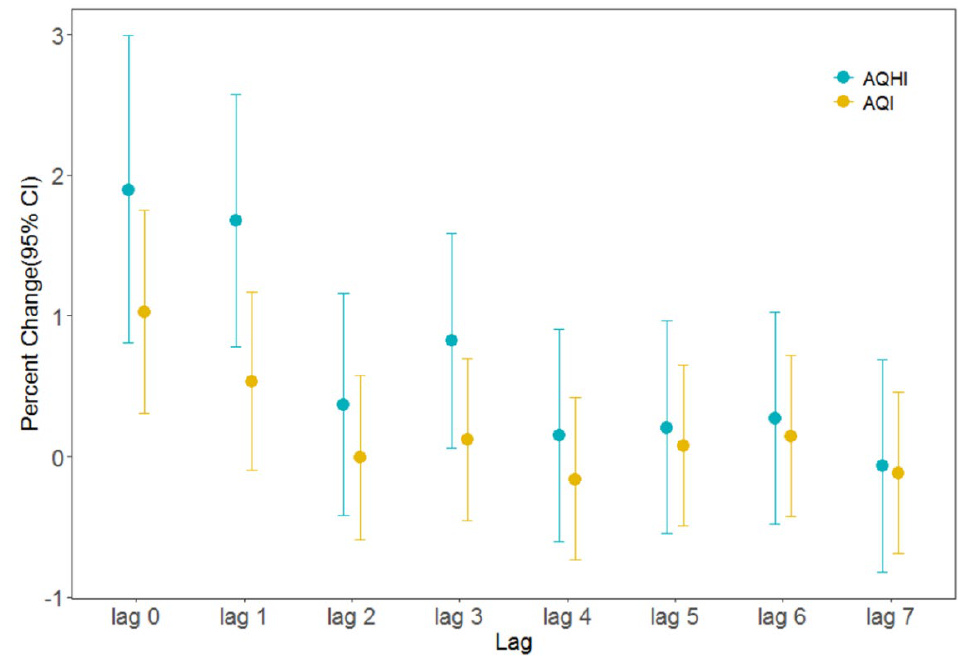
Figure 7. Comparison of the correlations of the AQHI and AQI with daily mortality in Beijing (2018−2020).